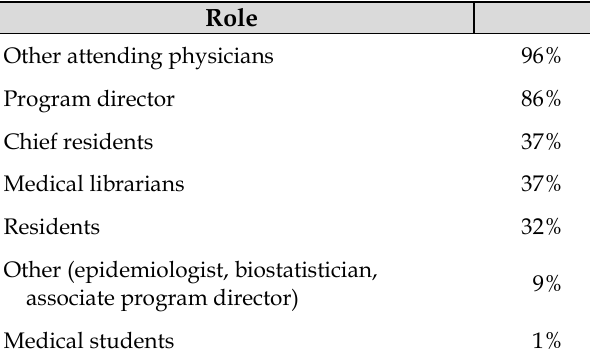
Table 4 Individuals responsible for teaching EBM